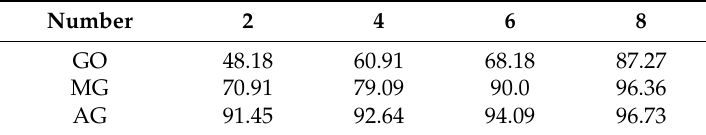
Figure 8. Diffusion coefficients of graphene containing various number of functional groups calculated at NVT ensemble at 300 K and 1 atm. Table 1. The reductions in diffusion coefficients for various graphene containing different numbers of functional groups at 300 K and 0.1 MPa (%).